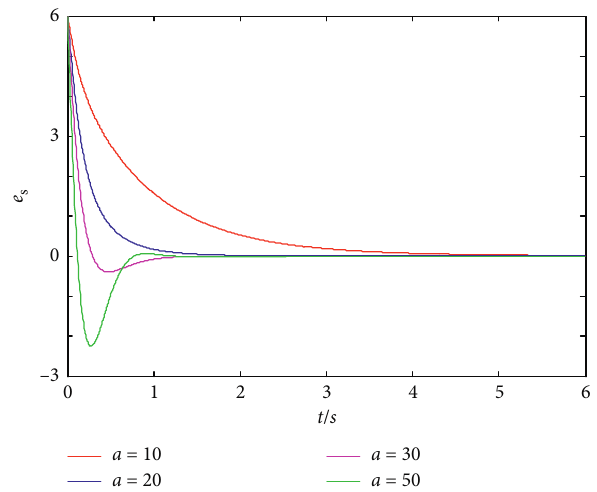
Figure 12: The estimation error of parameter s with different convergence